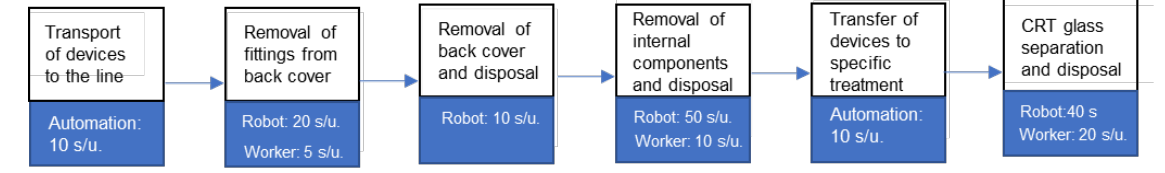
Figure 7. Flowchart of the disassembly process.